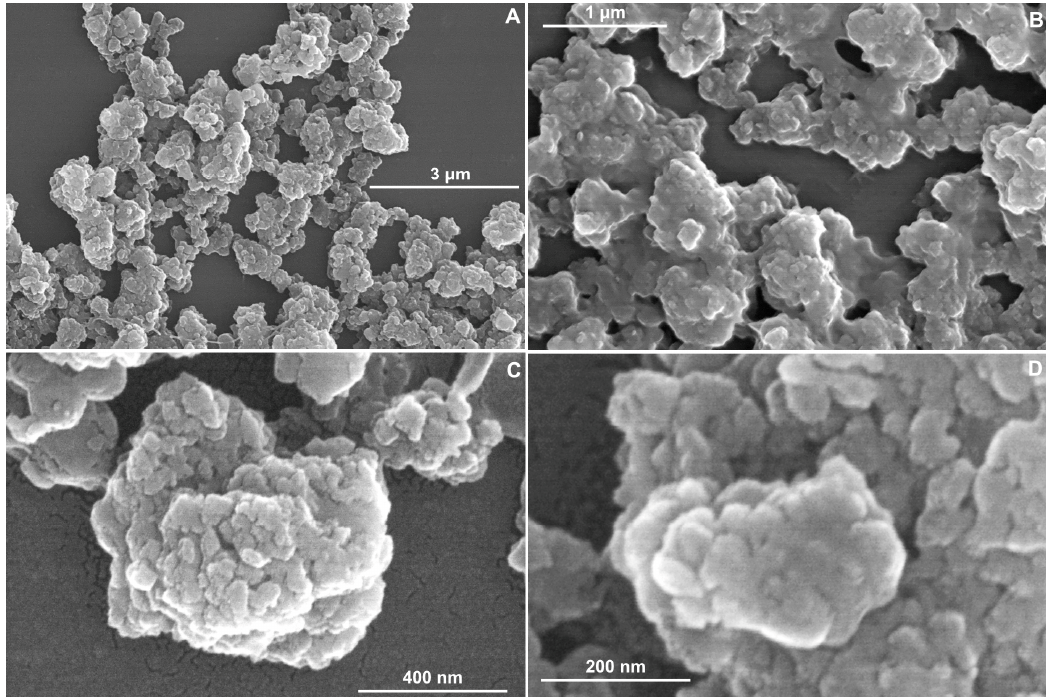
Figure 3. SEM images of TMPyP4/TiO 2 sample at different magnifications ( A ) 50,000 × ; ( B ) 100,000 × ; ( C ) 150,000 × ; ( D ) 250,000 × .